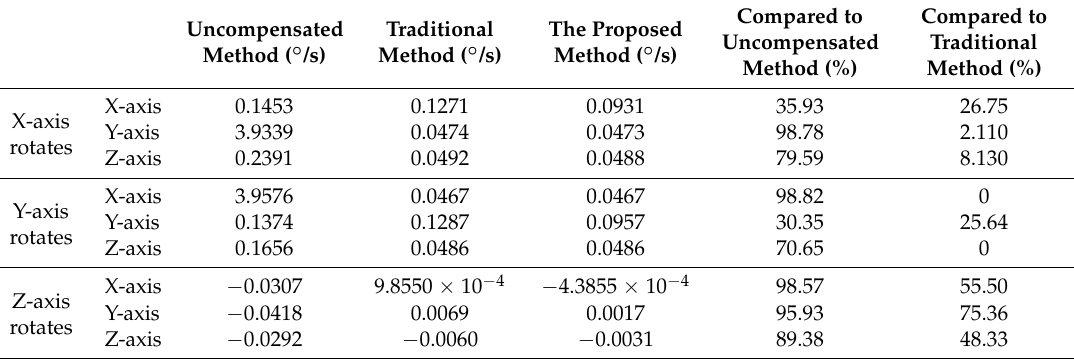
Figure 9. RMS of each axis when each axis rotates (determined using the uncompensated, proposed, and traditional methods). Table 4. RMS error difference comparison table.